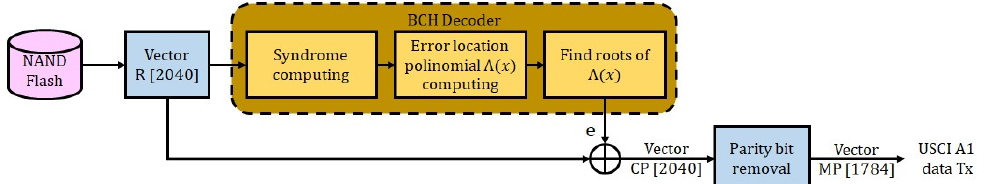
Figure 12. Block diagram of the reading NAND flash memory chip process. If the correction capability is grater than the errors, the error vector e contains the erroneous bits to be